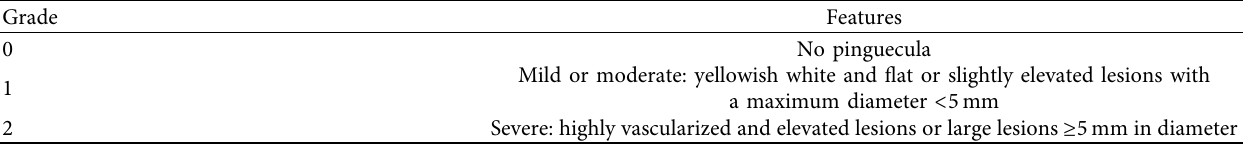
Table 1: Pinguecula grading